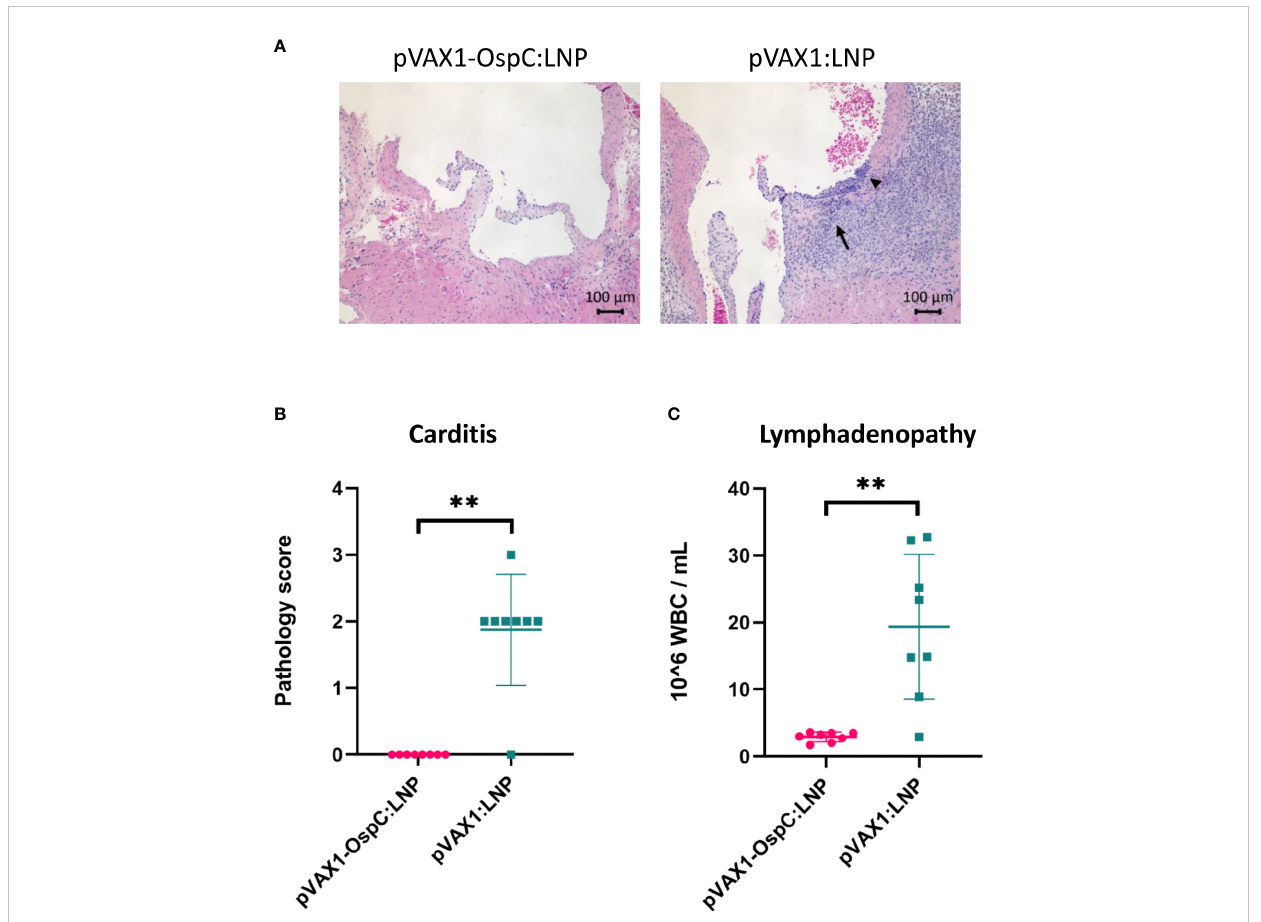
FIGURE 4 Vaccination with pVAX1-OspC:LNP prevents the development of carditis and lymphadenopathy. (A) Representative images of H&E stained heart tissue from mice vaccinated with pVAX1-OspC:LNP or pVAX1:LNP post-challenge. Arrows indicate moderate mononuclear-neutrophilic in fl ammation in the heart base (long arrow) and transmurally in the aortic origin (short arrowhead). (B) Summary of carditis pathology scores as determined by trained histopathologist. Scoring criteria is described in full in the methods section of this article. (C) White blood cell (WBC) counts from combined left and right axillary lymph nodes extracted from vaccinated mice two weeks after bacterial challenge. Error bars represent standard deviation. ** p-value <